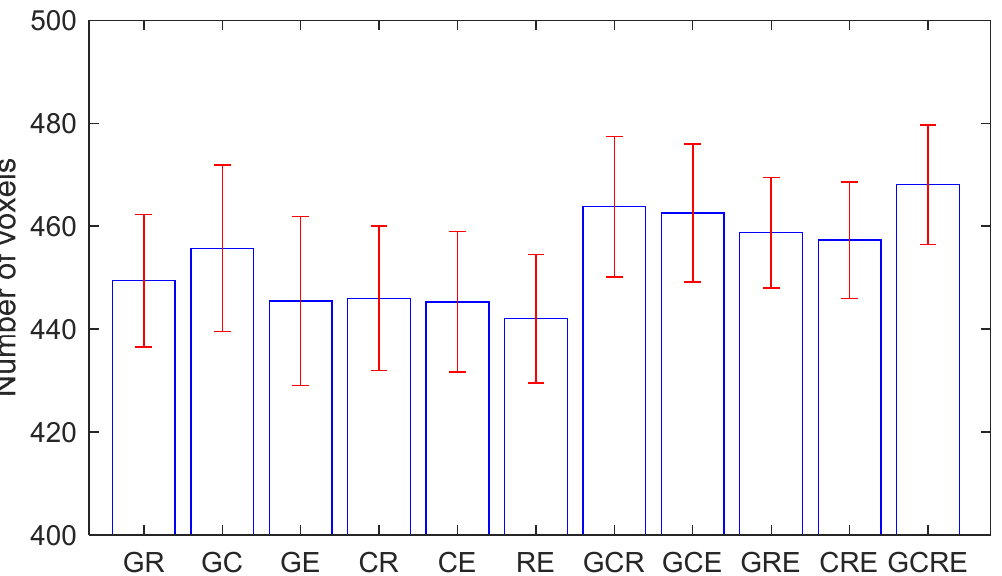
Figure 4. Average number of voxels penetrated by signal rays in each solution based on different combination during the experimental period. Table 1. Average number of voxels penetrated by sufficient signal rays based on different satellite systems and different combinations during the experimental